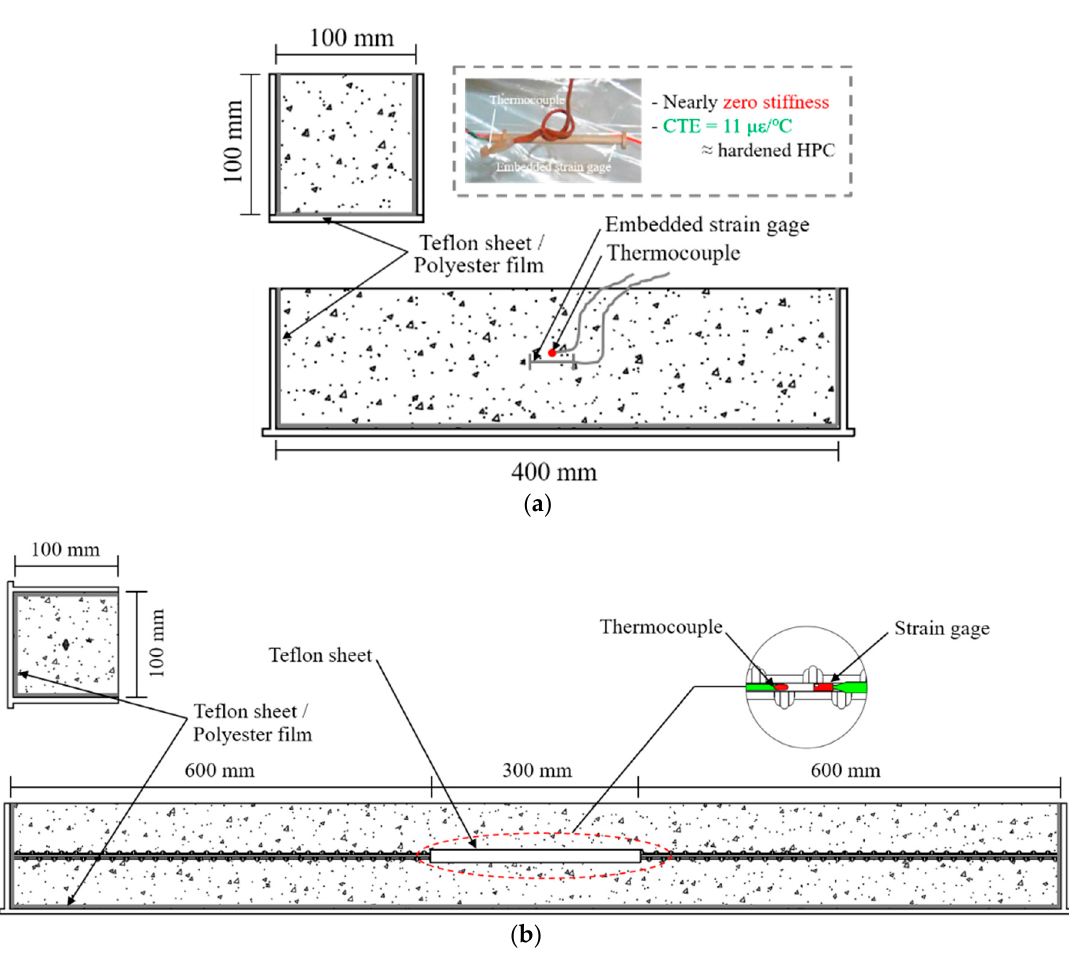
Figure 2. Test setup for autogenous shrinkage strain; ( a ) free condition and ( b ) restrained condition.